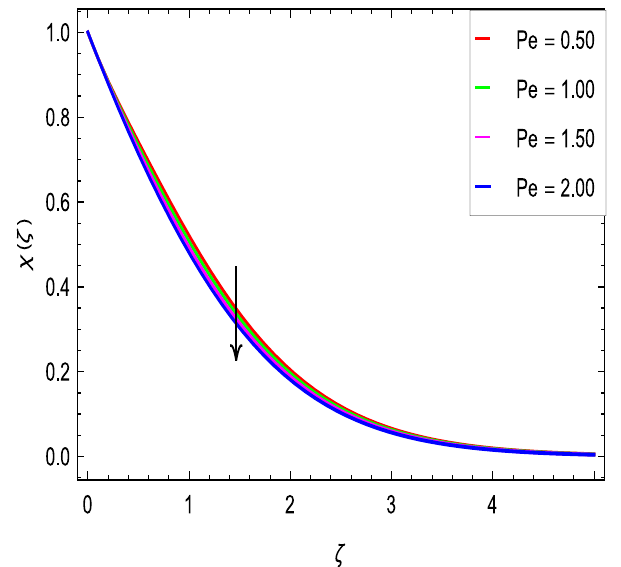
Figure 24. χ(ζ) in terms of Pe .